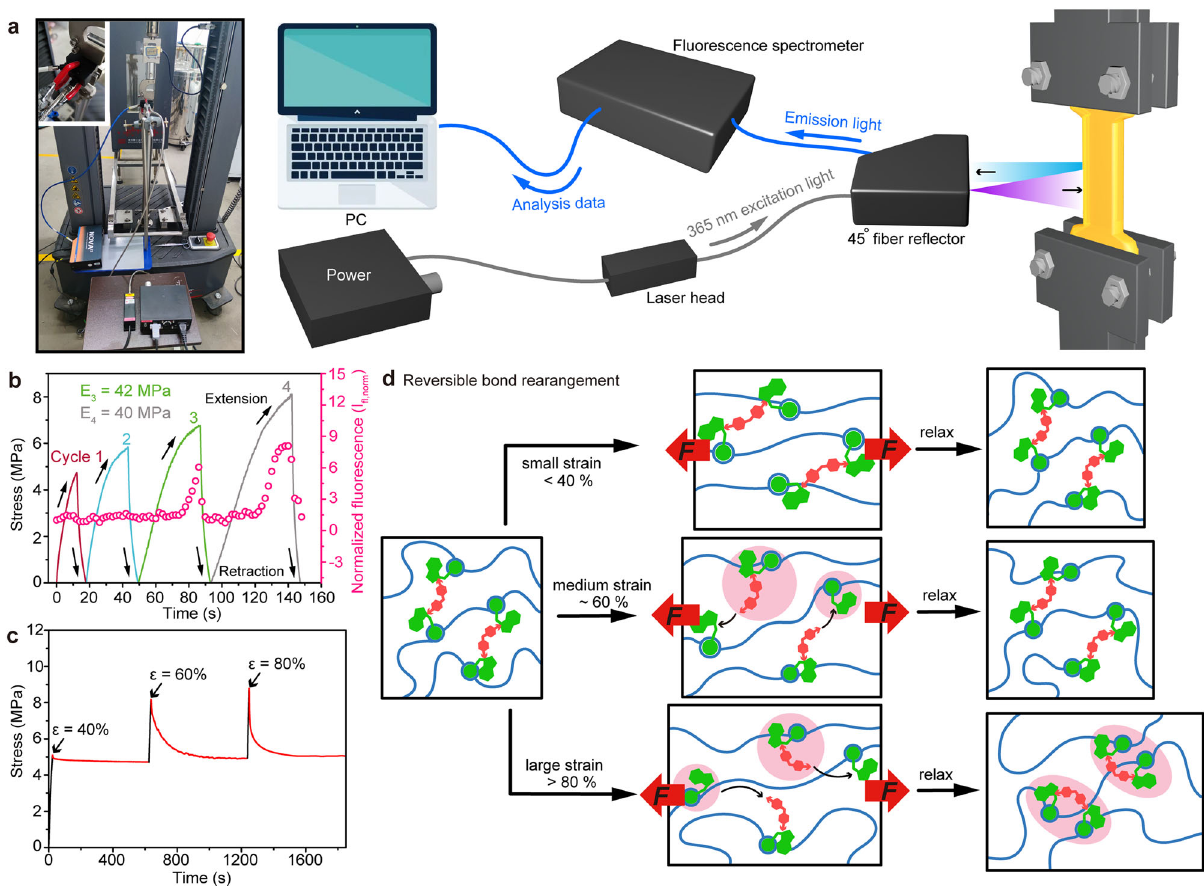
Fig. 5 The recovery mechanism and kinetics of the reversible C-N bonds. a Design of the customized setup, combining the use of a universal testing machine and portable fl uorescence spectrometer, λ exc = 365 nm. b Simultaneously obtained stress and thickness-corrected normalized fl uorescence intensity as a function of strain. c The repeated stress relaxation of CPMA at ε = 40%, 60% and 80%, respectively. Relaxation time is 10 min for every stage. d Schematic representation of proposed bond rearrangements for the strain